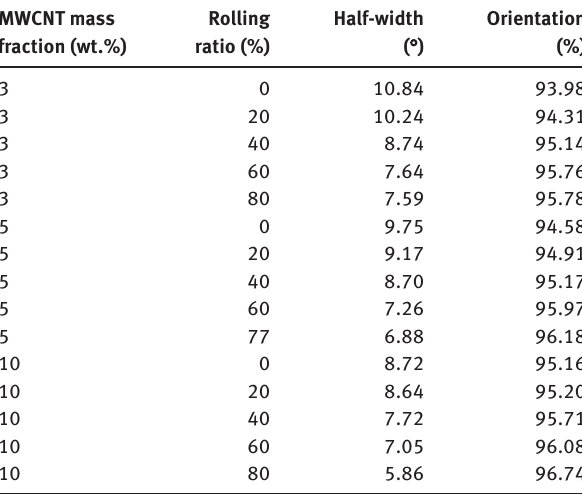
Table 2: Orientation of PLA/MWCNT composites at various rolling ratios. MWCNT mass fraction (wt.%)